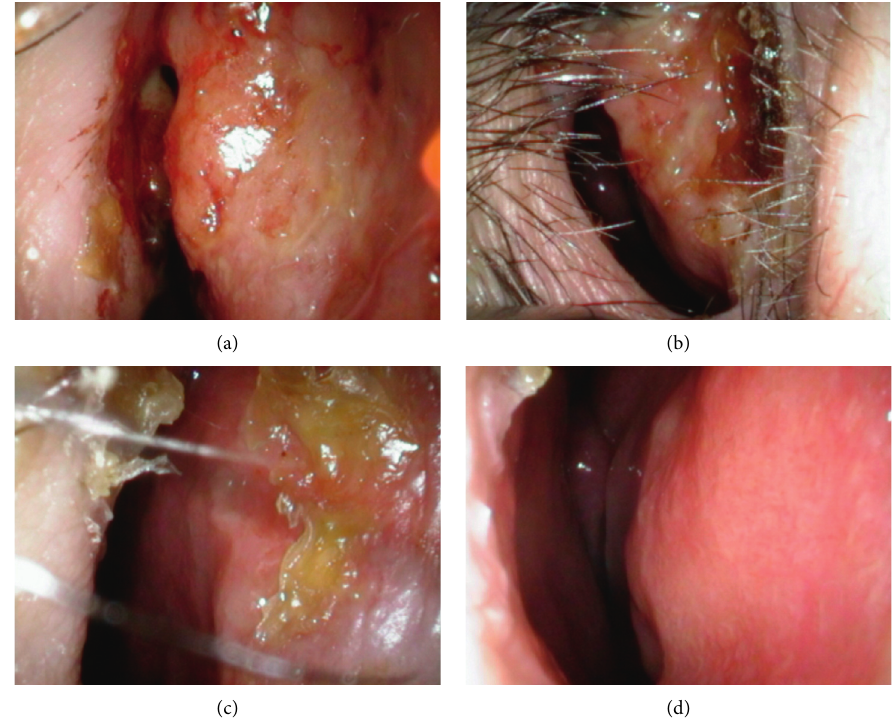
Figure 3: Complete resolution of lesions occurred in response to 4 weeks of oral minocycline (100mg twice daily) followed by 4 weeks of clarithromycin (200 mg twice daily) and discontinuation of infliximab. (a) 2 weeks later. (b) 4 weeks later. (c) 6 weeks later. (d) 8 weeks